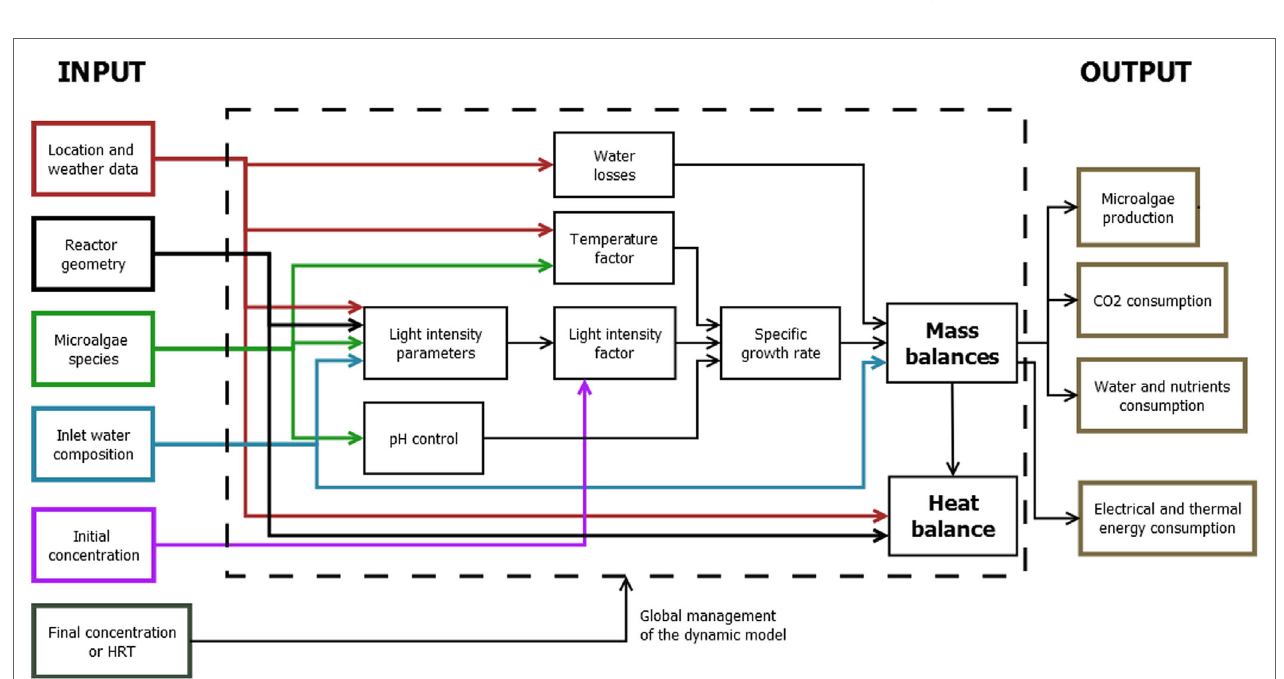
FigUre 3 | Model structure